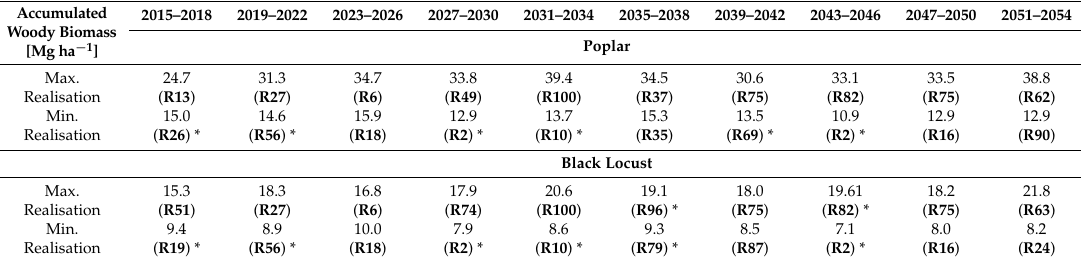
Table 3. Realisations (R, highlighted in parentheses) that rendered minimum and maximum accumulated woody biomass values for both tree species with respect to the ten established growing periods.